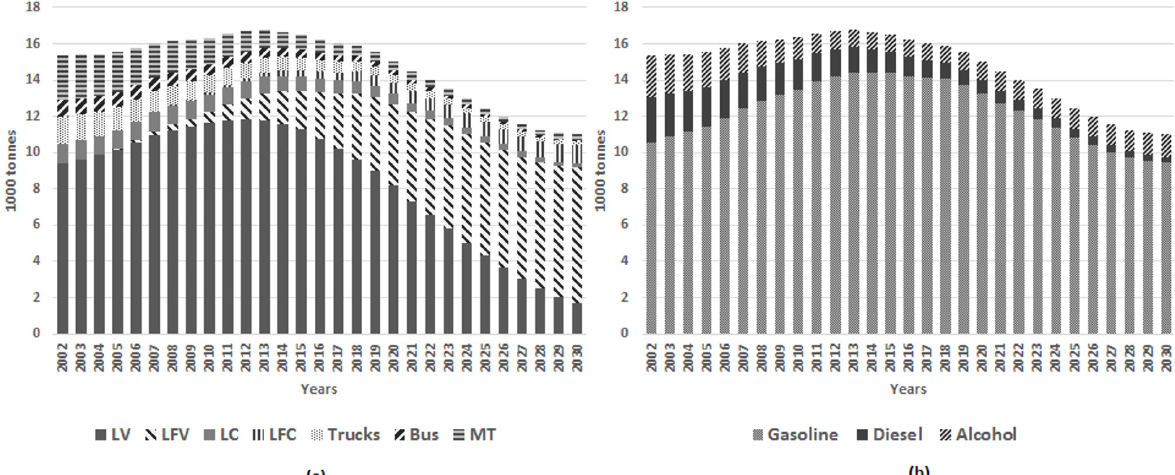
Figure 5 - Scenarios of THC emission in the MRPA (associated with the pessimistic estimation of the fleet) for the period between 2002 and 2030. ( a ) Scenarios by vehicles categories. ( b ) Scenarios by type of